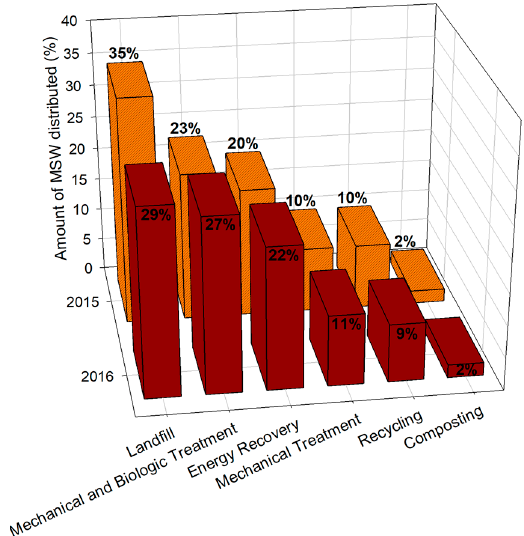
Figure 2. Portuguese MSW distributed by treatment type (2015 and 2016).